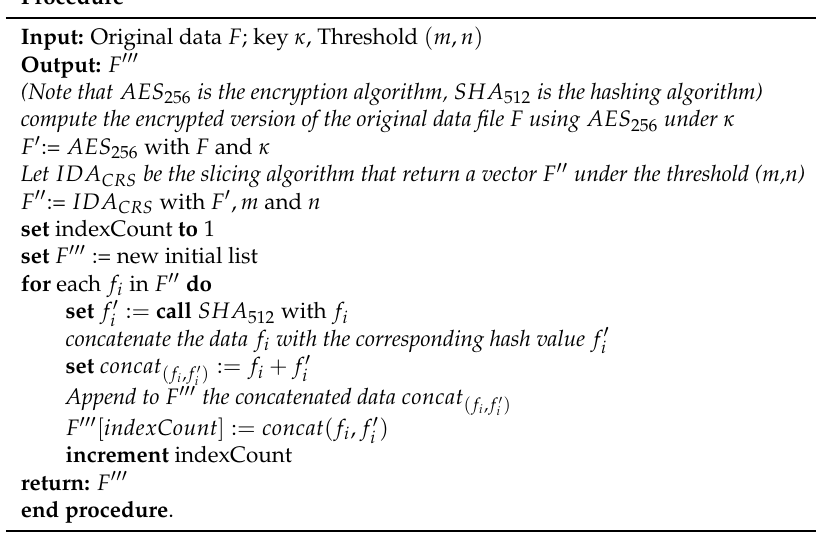
Table 2. Encoding algorithm pseudo code.